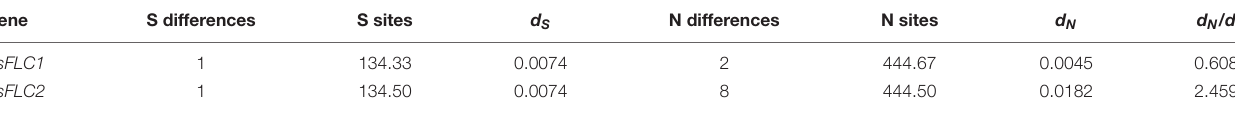
This table compares the difference between each gene and the ancestral sequence before gene duplication. Columns: S differences, number of synonymous differences; S sites, number of synonymous sites; d S , S differences/S sites; N differences, number of nonsynonymous differences; N sites, number of nonsynonymous sites; d N , N differences/N